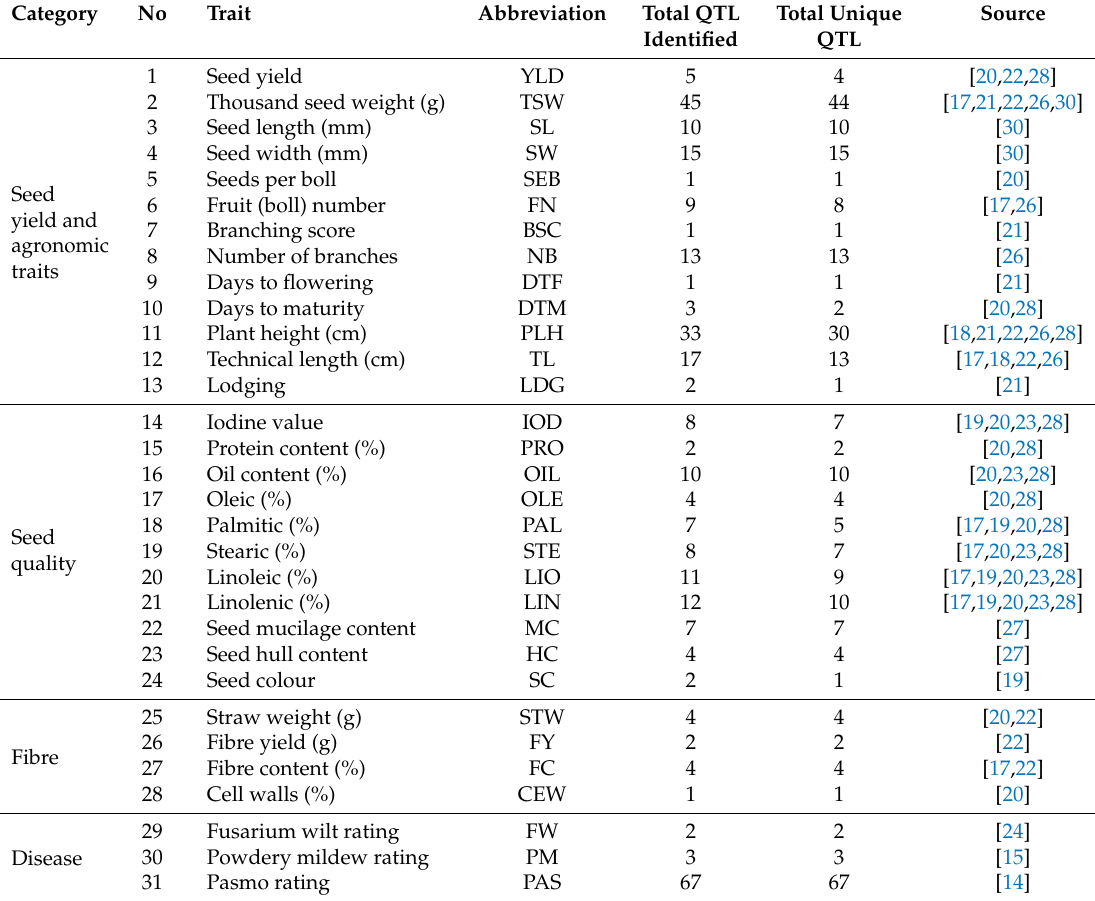
Table 1. Number of QTL associated with 31 traits in